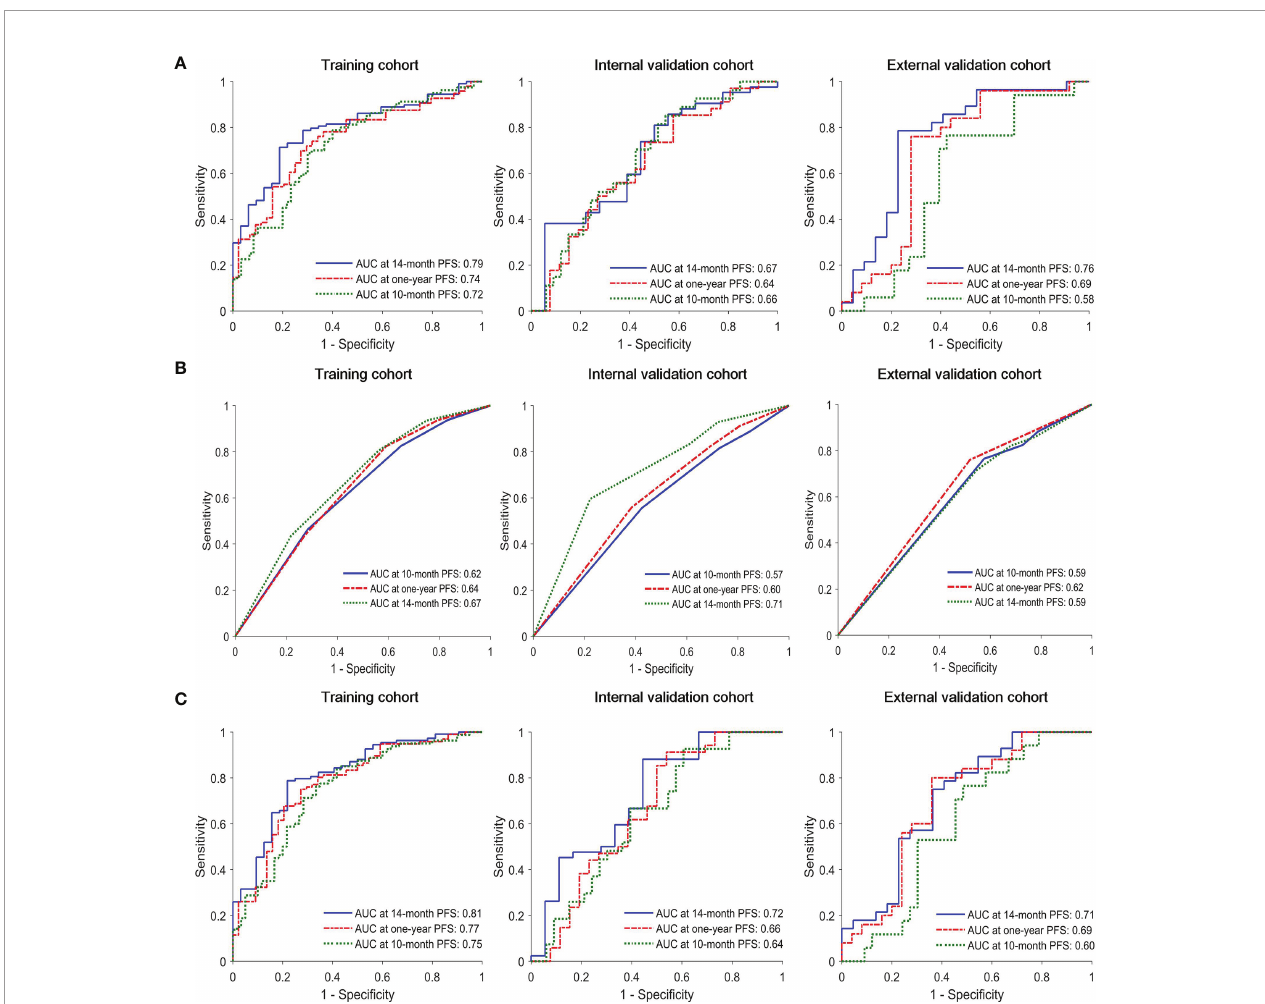
FIGURE 1 | Time-dependent receiver operating characteristic (ROC) curves of (A) radiomics model, (B) clinical model and (C) combined model in the training, interval validation, and external validation